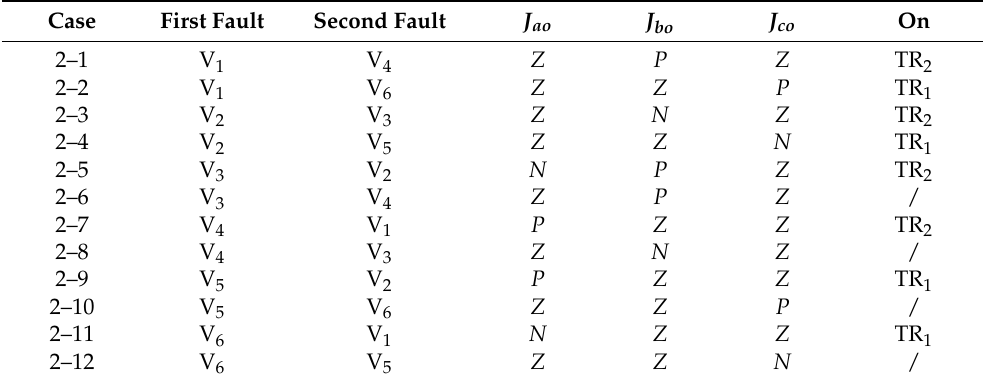
Table 3. Second fault diagnosis and reconfiguration.